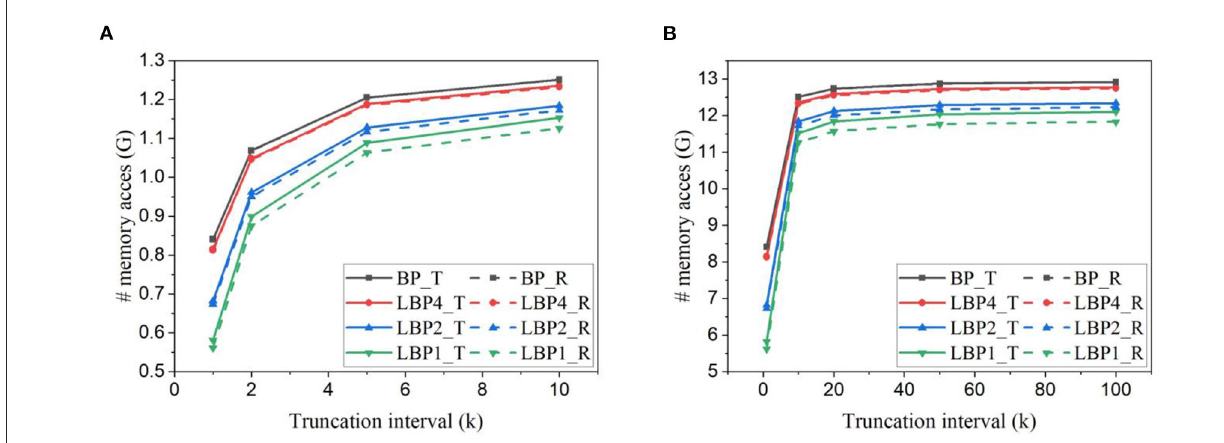
FIGURE10 Number of memory access estimated for training AlexNet (A) on CIFAR10 dataset and (B) on CIFAR10-DVS dataset.